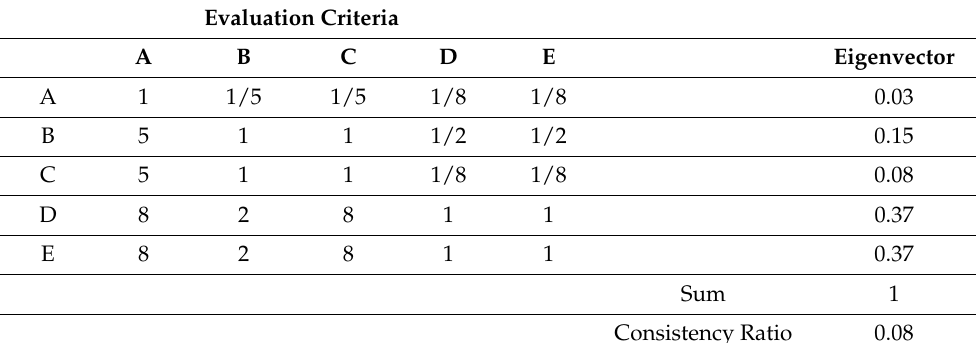
Table 1. Synthetic example of the paired prioritization of evaluation criteria, including the resulting criteria weightings